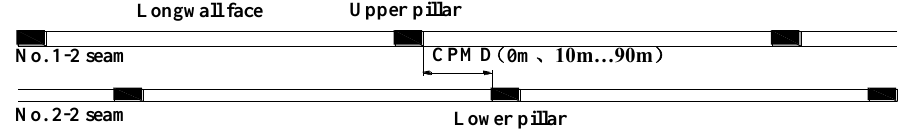
Figure 6. CPMD of coal seams.